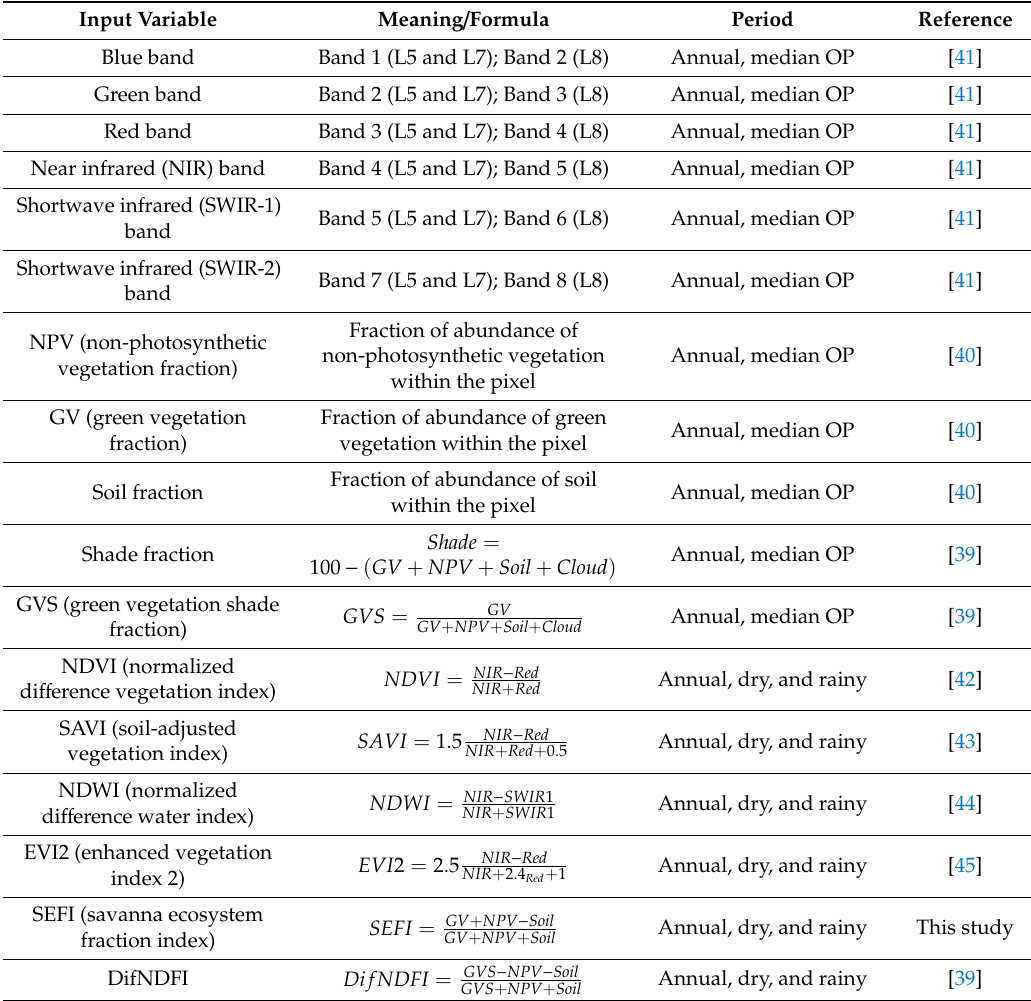
Table 1. List of predictive input spectral variables considered to be included in the empirical decision tree classification. The median statistics were applied to all variables. L5 = Landsat-5; L7 = Landsat-7; L8 = Landsat-8; Cloud = fractional abundance of cloud within the pixel; OP = optimum